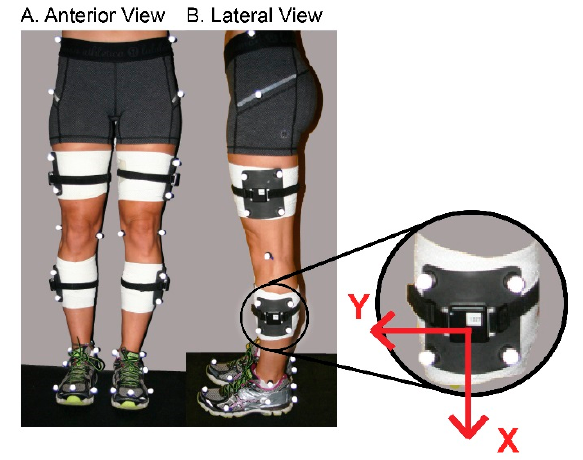
Figure 1. Orientation and location of inertial sensors and markers on thigh and shank during testing; Orientation of axes depicted on right.